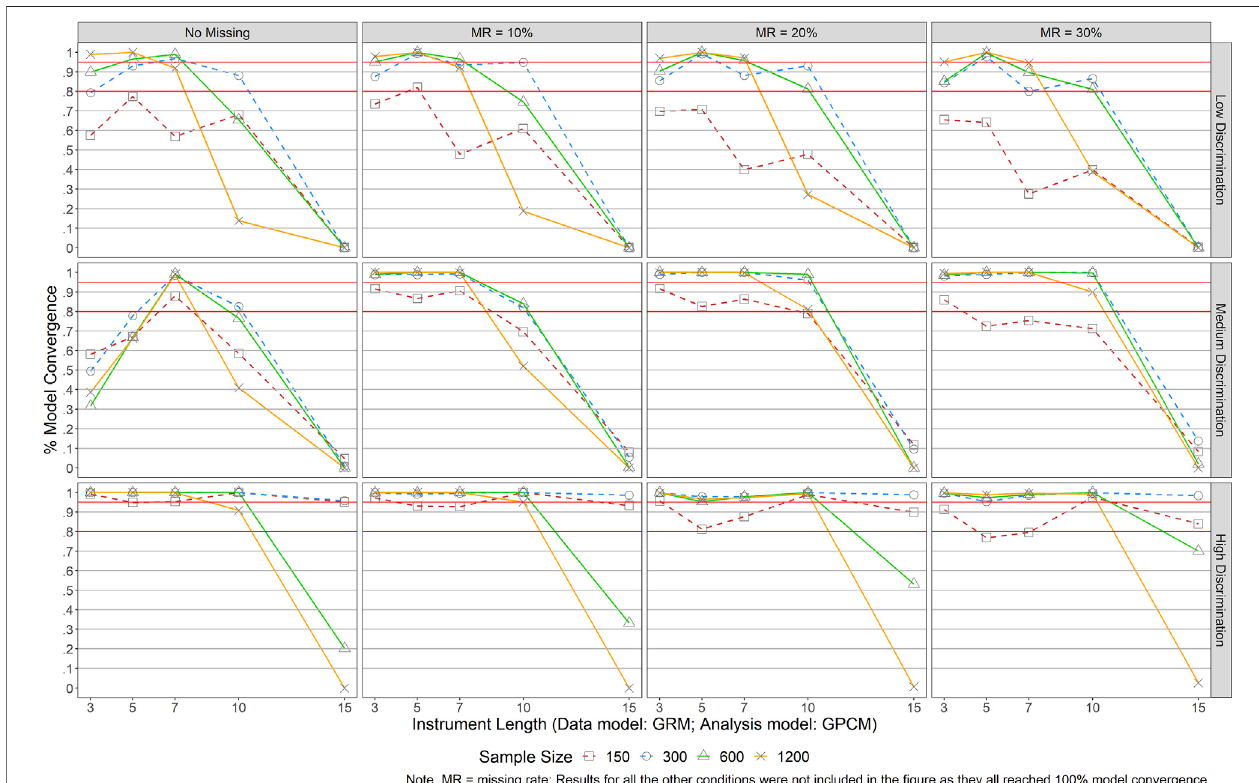
FIGURE 1 | Results of Model Convergence When Data Were Generated by GRM but Analyzed with GPCM. Note. MR (cid:1) missing rate; Results for all the other conditions were not included in the fi gure as they all reached 100% model